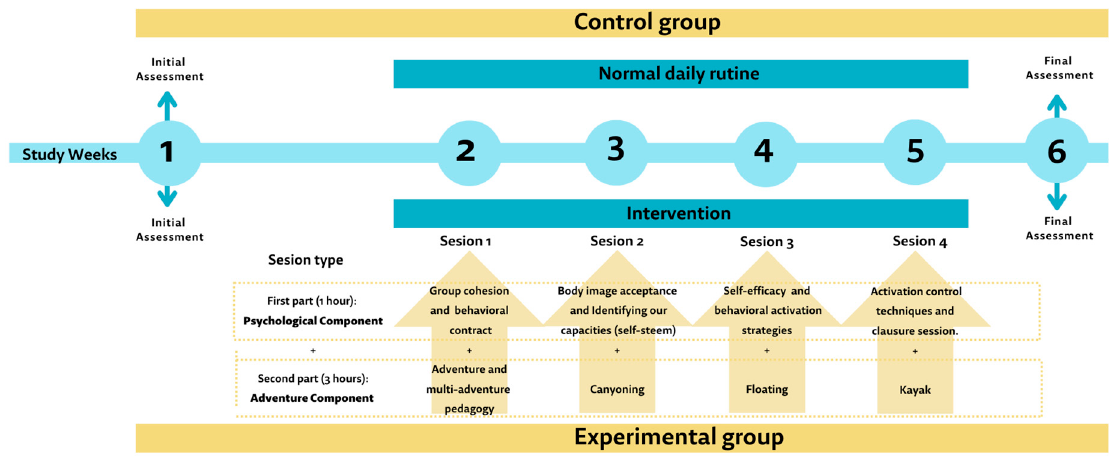
Figure 1. Intervention